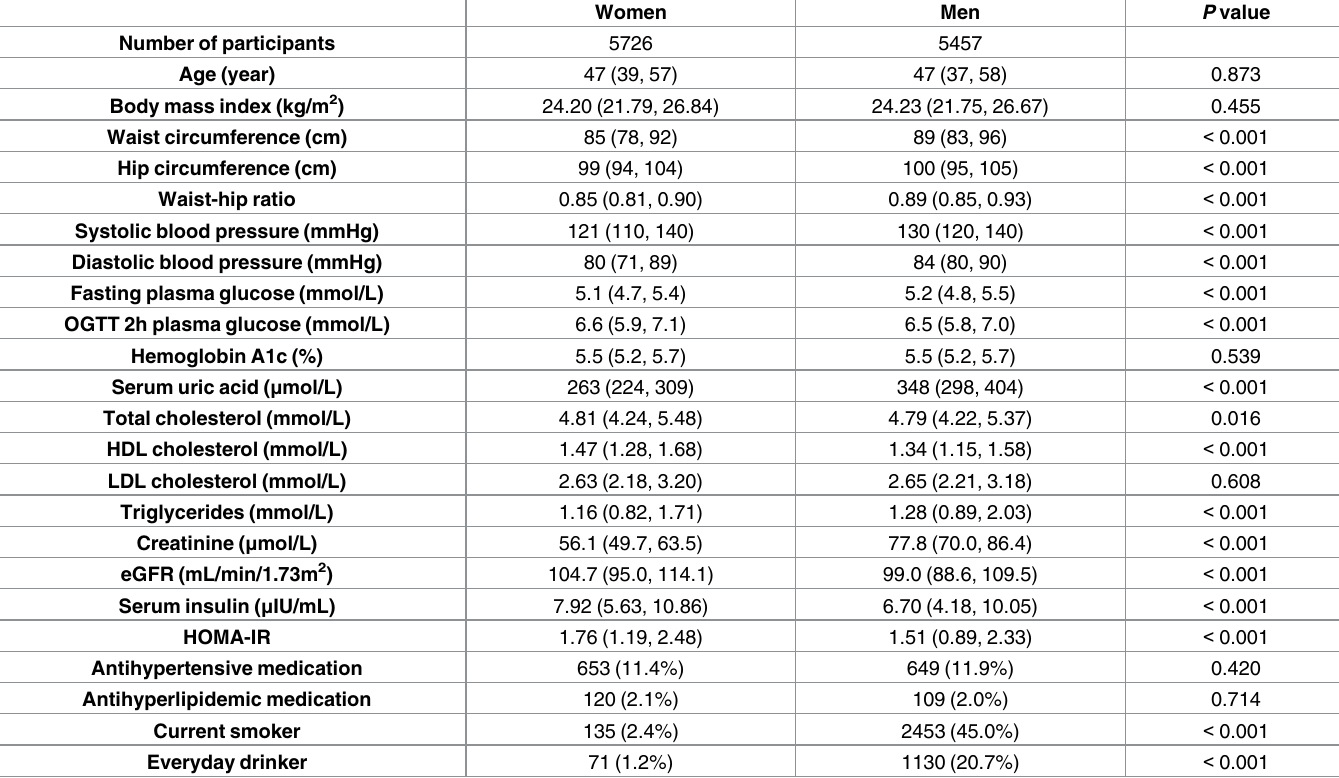
Table 1. Clinical and metabolic characteristics of the study population by gender.